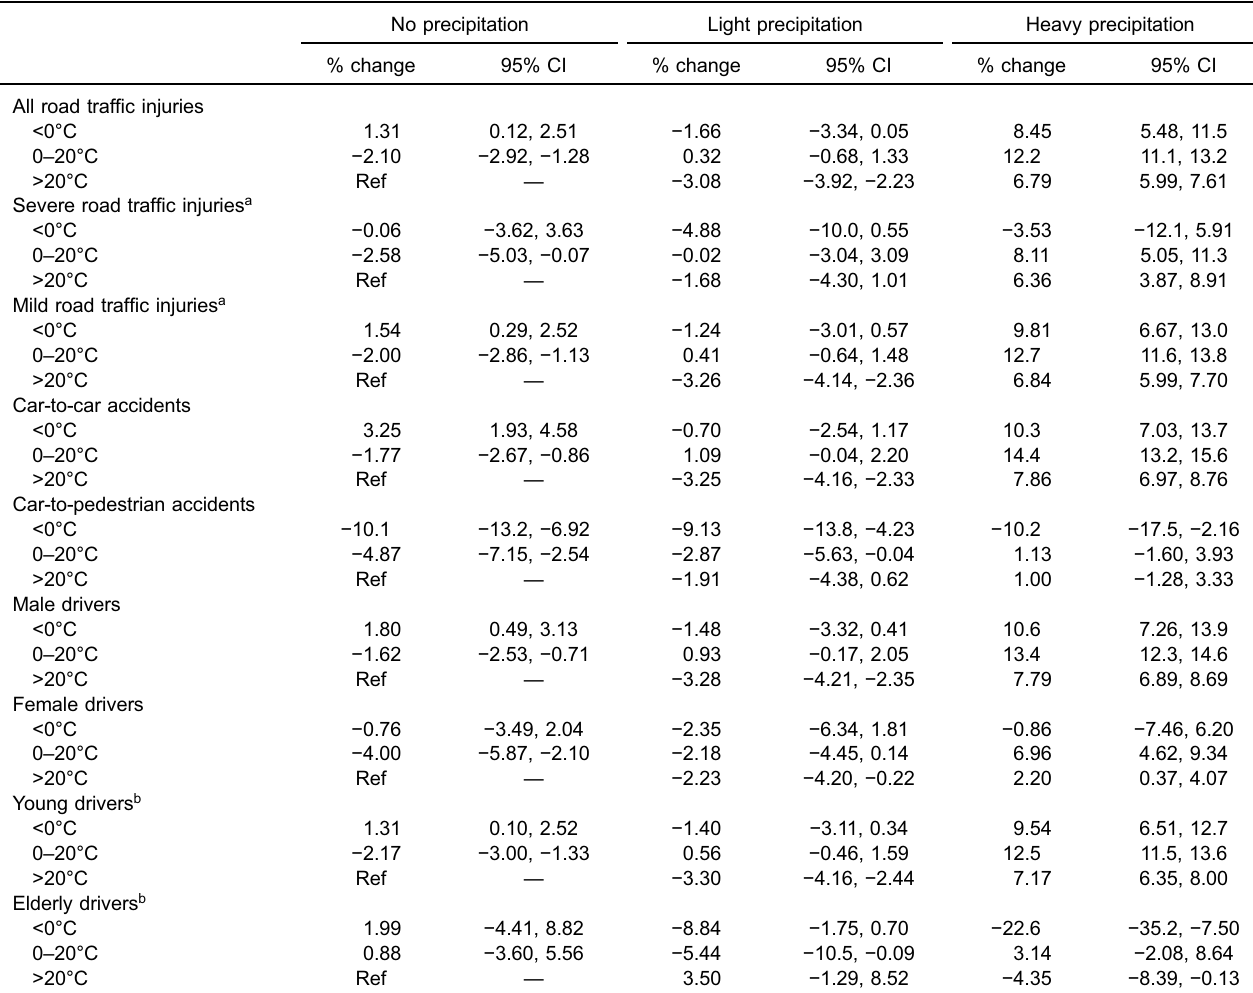
Table 4. Effect of the relationship between temperature and amount of rain precipitation on road traf fi c injuries, 2007 to 2011 No precipitation Light precipitation Heavy